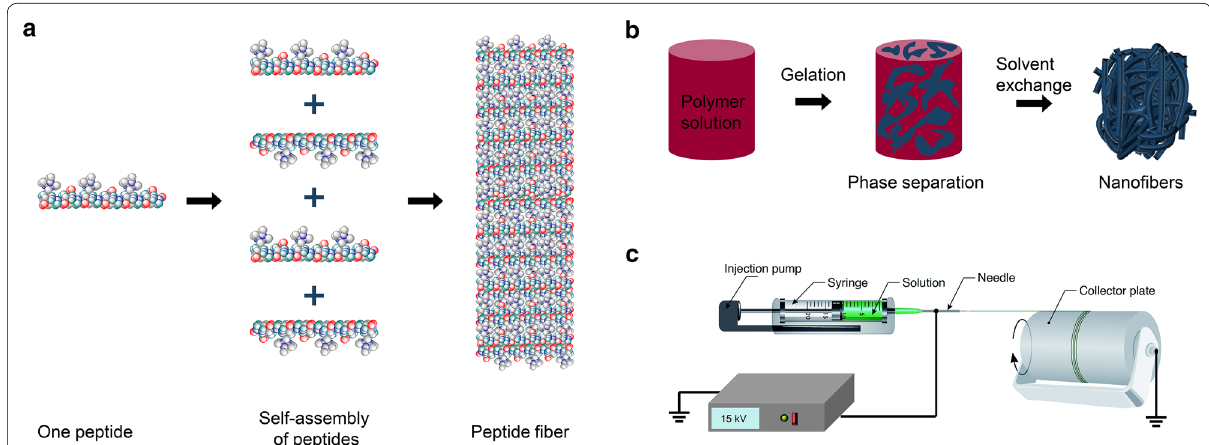
Fig. 2 Schematic diagram of nanofiber fabrication techniques. a Self‑assembly. Reproduced with permission from [24], Nature publication. b Phase separation. Reprinted with the permission from [40], Royal Society of Chemistry (RSC). c Electrospinning. Reproduced with permission from [50], Royal Society of Chemistry